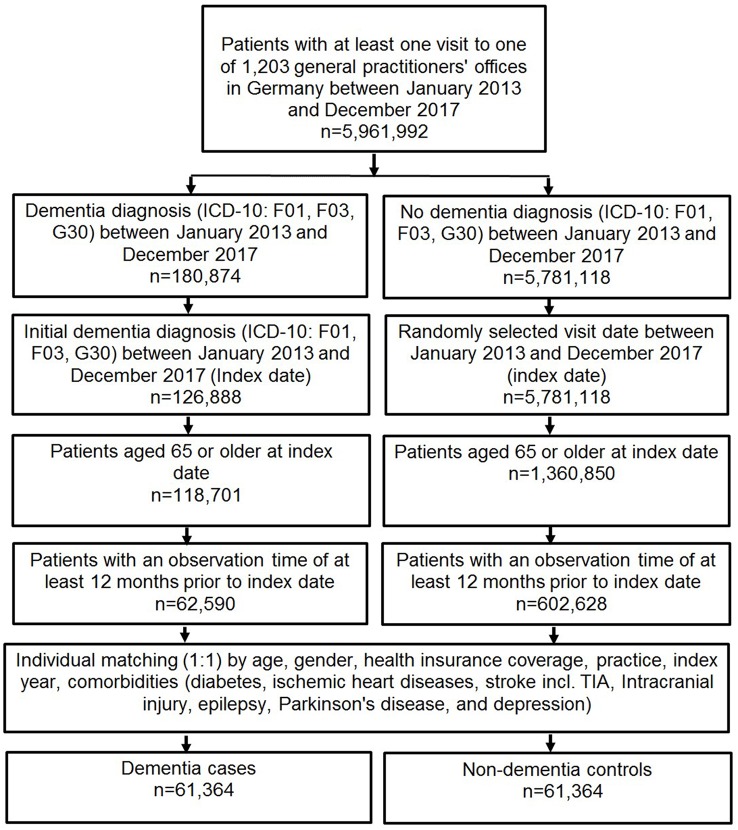
Study flow chart.